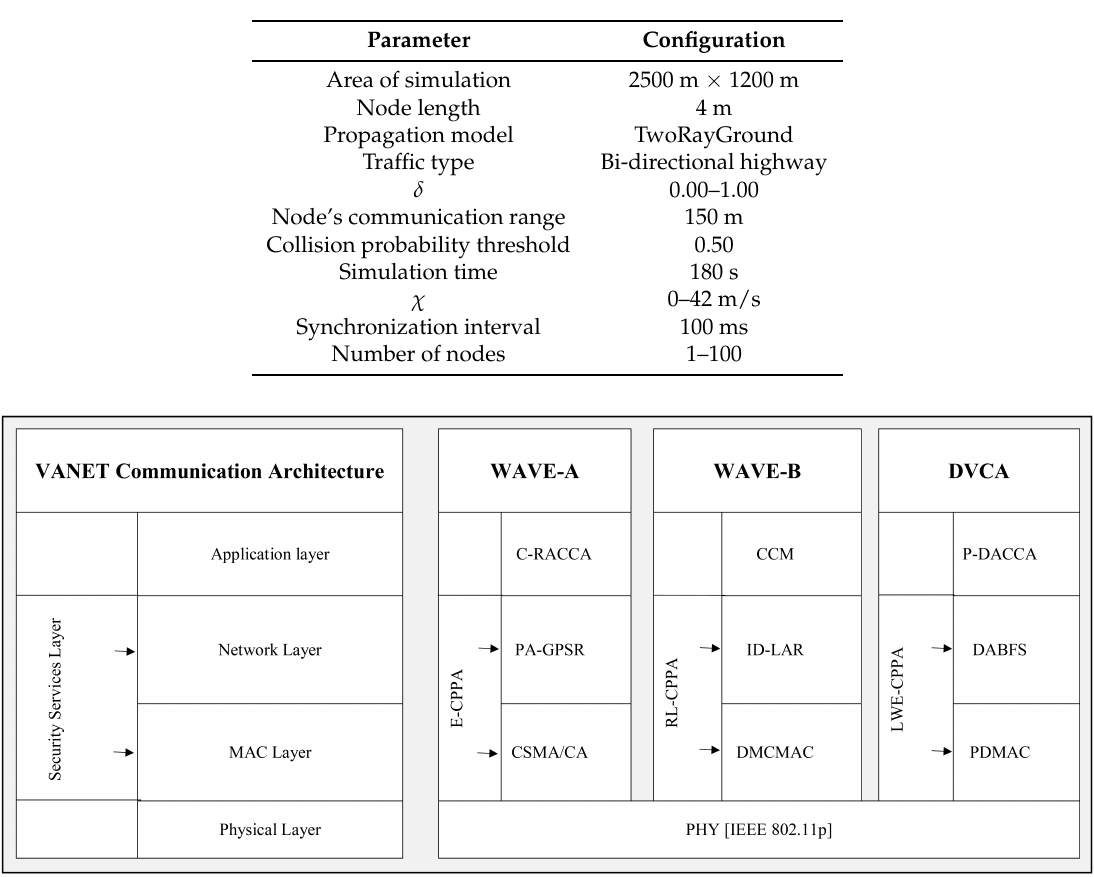
Table 3. Parameters for simulations.